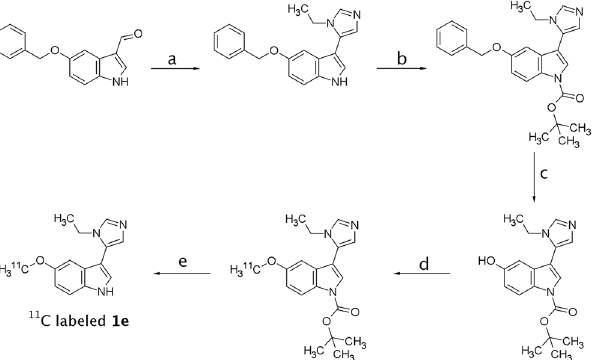
Figure 9. Proposed synthetic scheme for the synthesis of radiolabeled 1e . Conditions: (a) – EtNH 2 , TosMIC, K 2 CO 3 , MeOH (85% - yield); (b) – Boc 2 O, DMAP, THF (85% yield); (c) – Pd/C, H 2 , MeOH (36% yield); (d) – 11 CH 3 I, NaOH, toluene, H 2 O, TBAB (25% yield); (e) – HCl, MeOH (97%